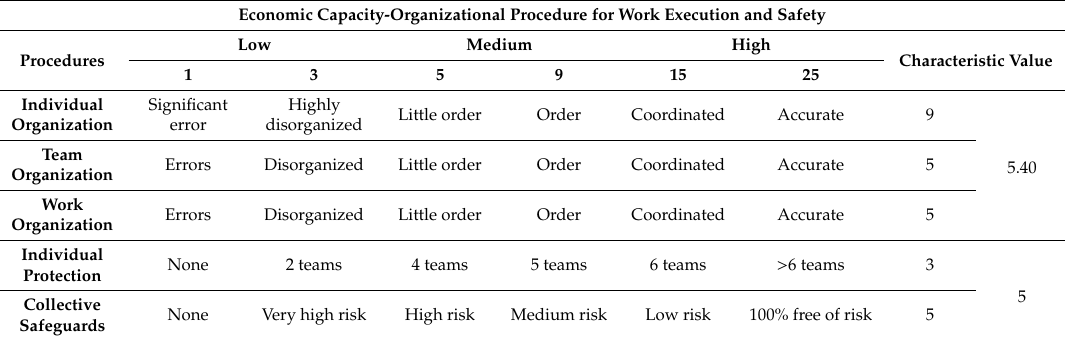
Table 7. Example of characteristic value in economic